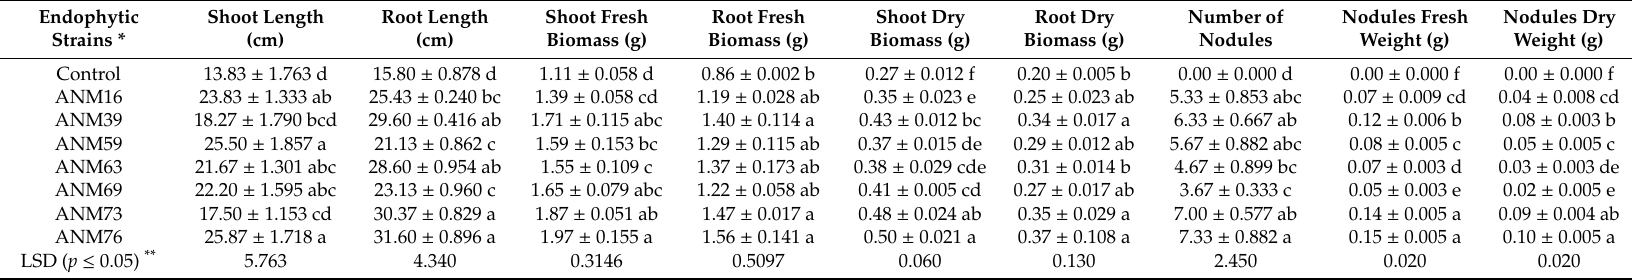
Table 4. Endophytic strains promoted growth and nodulation in chickpea under the jar